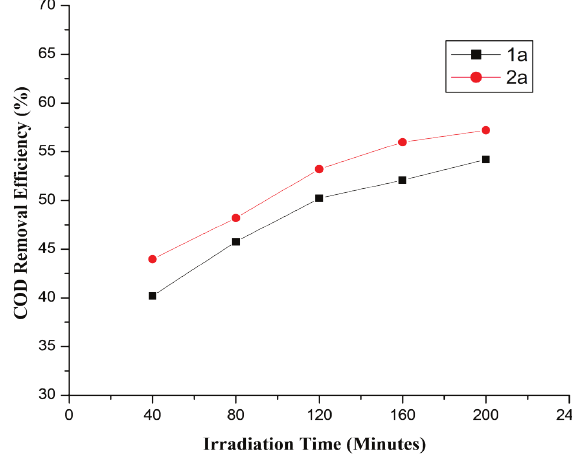
Figure 5: Effect of irradiation time on COD removal efficiency of UV absorbers (1a-2a) in UV/H